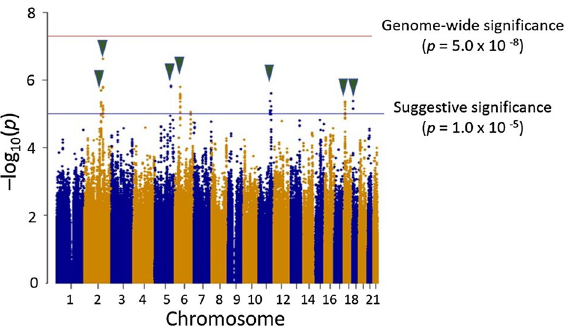
Figure 1. Manhattan plot of AESD GWAS after whole-genome imputation. The horizontal red and blue lines show genome-wide significance ( p < 5.0 × 10 −8 ) and suggestive significance level ( p < 1.0 × 10 −5 ), respectively.